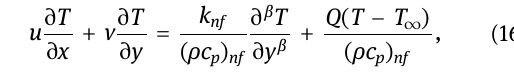
Table 2: Physical properties of nano fl uids [ 56